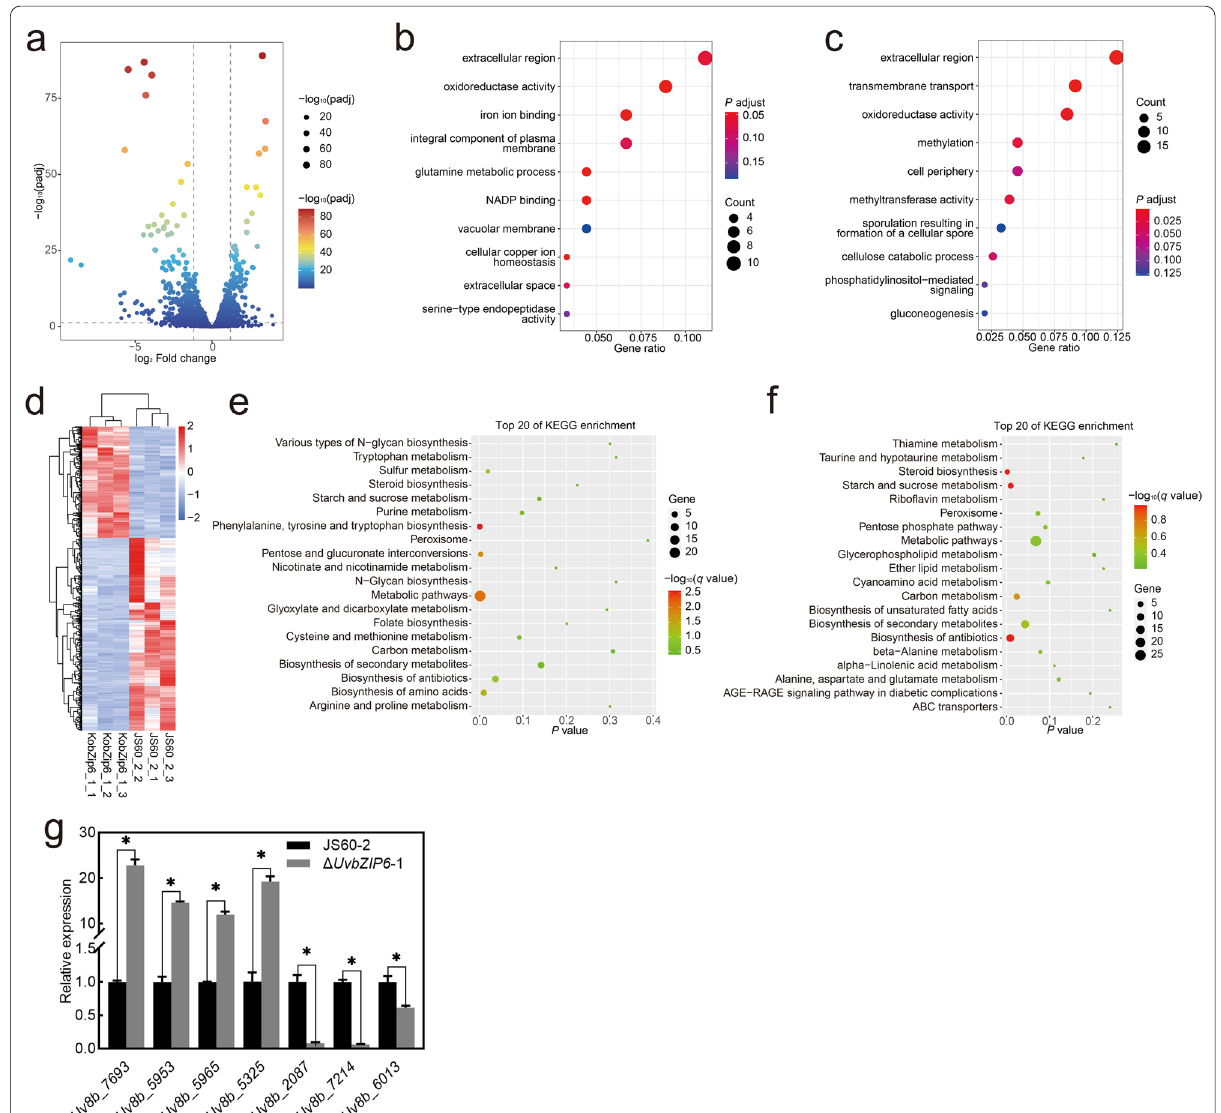
Fig. 8 Transcriptomic analysis to identify differentially expressed genes (DEGs) between the UvbZIP6 -knockout mutant and the wild-type strain JS60-2. a Volcano plot of DEGs. b , c Gene ontology enrichment analysis of the DEGs, showing up-regulated DEGs in b and down-regulated DEGs in c . d Heatmap of FPKM-normalized transcript levels of the 565 DEGs in each pair-wise comparison. e , f Top 20 up-regulated ( e ) and down-regulated DEGs ( f ) in the KEGG enrichment analysis. g qPCR analysis to validate the DEGs. The relative transcript level of each gene from ∆ UvbZIP6 was normalized by comparison with the gene from JS60-2 (relative transcript level 1.0). Asterisks indicate the significant differences between the = mutant and JS60-2 ( P < 0.05). Error bars represent standard